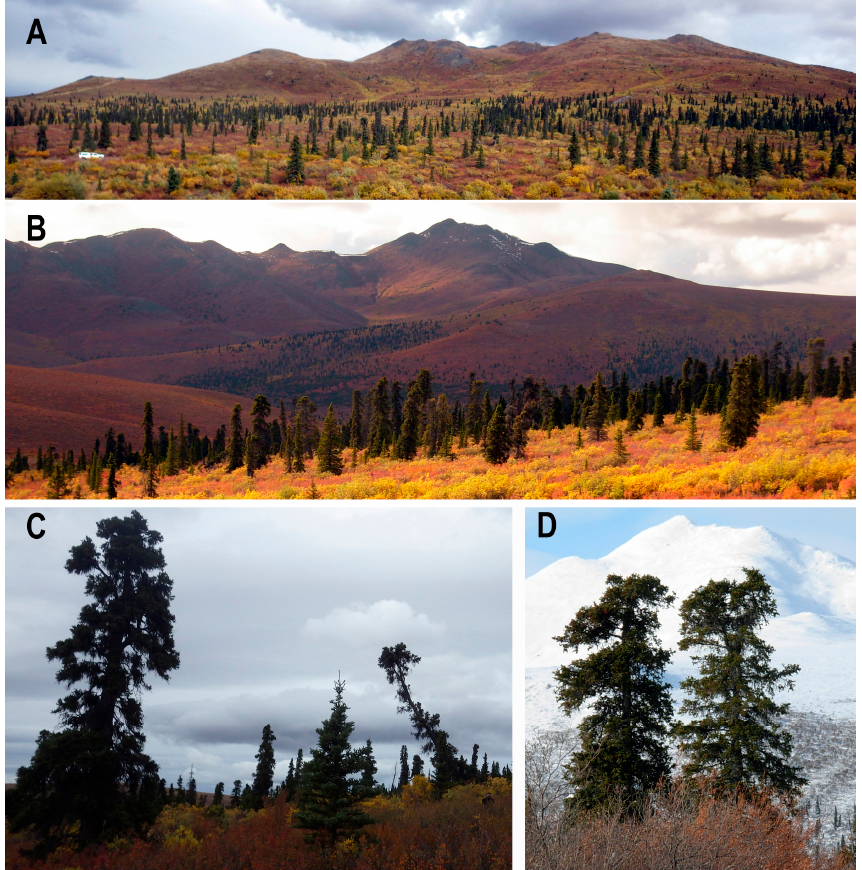
Figure 2. The investigated site in early September ( A – C ) and early October ( D ) 2007. ( A ) Looking north, the foreground trees are at 1240 m asl and those at highest elevation are near 1400 m asl. The vehicle is 6 m in length. Horizontal distance between the left summit and the highest summit on the right is 1.25 km. ( B ) The same site looking west with Mount Nansen in the distance and the confluence of East Fork Creek with Nansen Creek the lowest point. ( C , D ) Closer views of the white spruce trees on site, all widely spaced and full crowned; some lean due to downslope slippage over melting